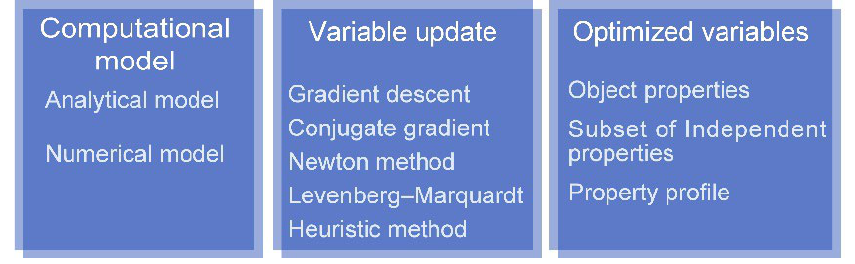
Figure 7. Primary issues of parameter